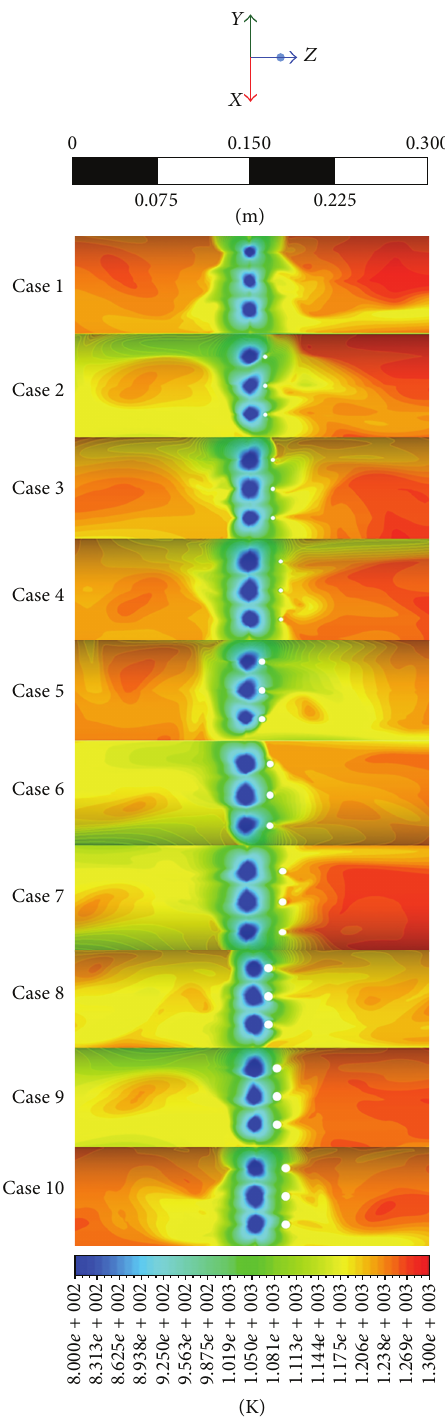
Figure 4: Contours of inner wall